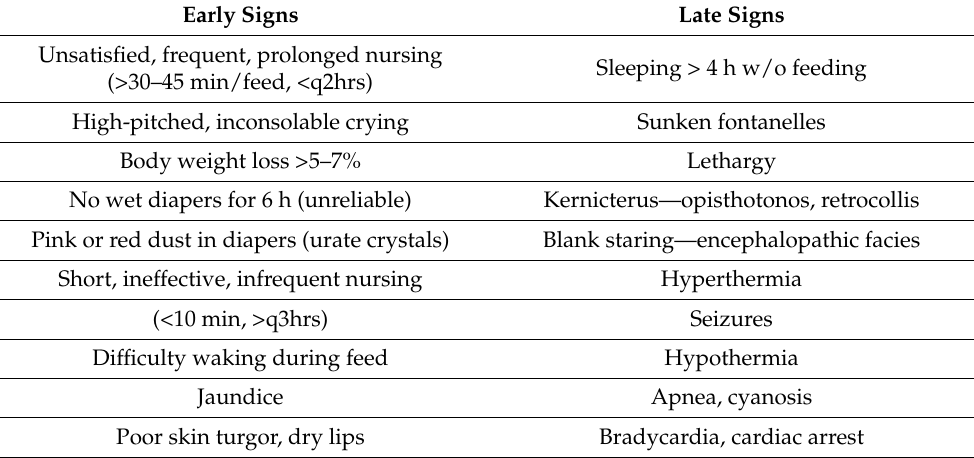
Table 3. Clinical presentation of hypernatremia [25,44,46–48]. Early Signs Late Signs Unsatisfied, frequent, prolonged nursing Sleeping > 4 h w/o feeding Sunken fontanelles Lethargy Kernicterus—opisthotonos, retrocollis Pink or red dust in diapers (urate crystals) Blank staring—encephalopathic facies Short, ineffective, infrequent nursing Hyperthermia